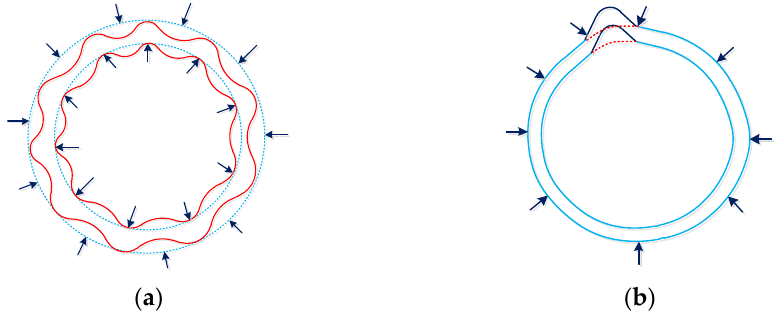
Figure 5. Windings deformation under radial force: ( a ) forced flexion; ( b ) free flexion.